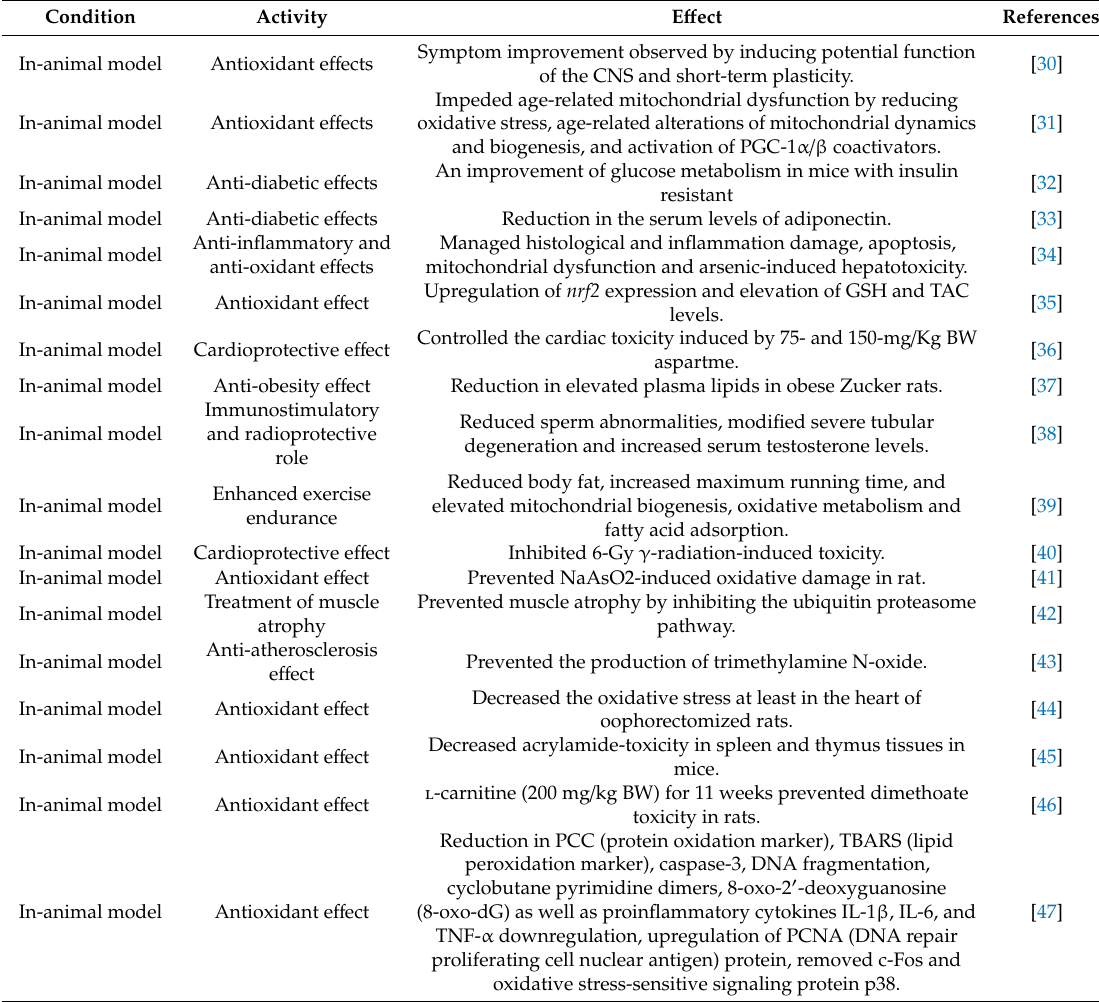
Table 2. An updated picture of studies based on l -carnitine conducted inanimal